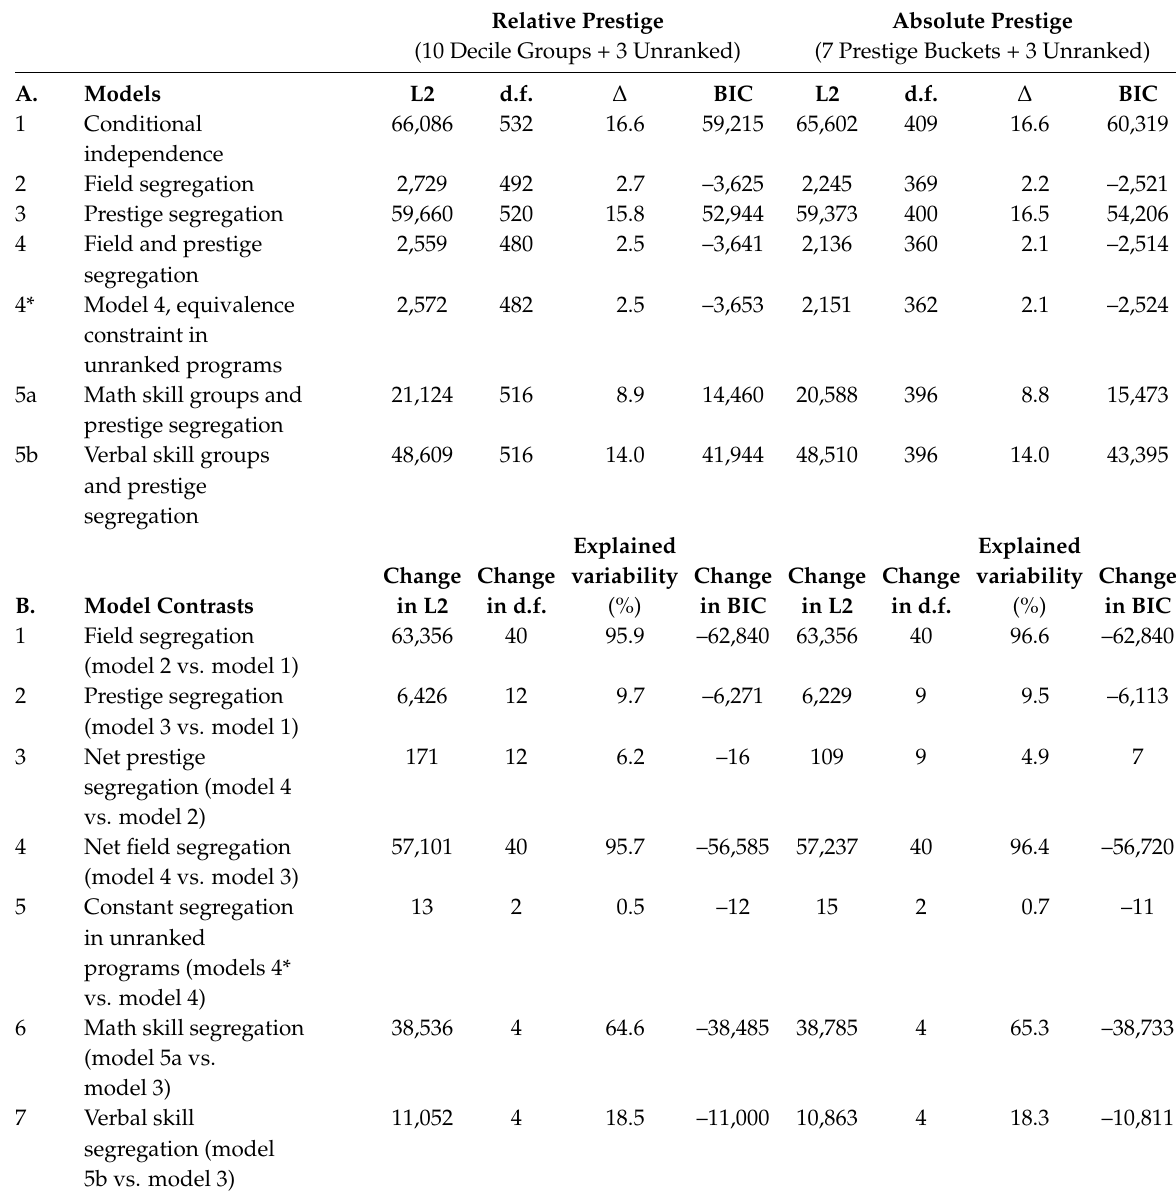
Table 2: Fit statistics for basic log-multiplicative models of field and prestige